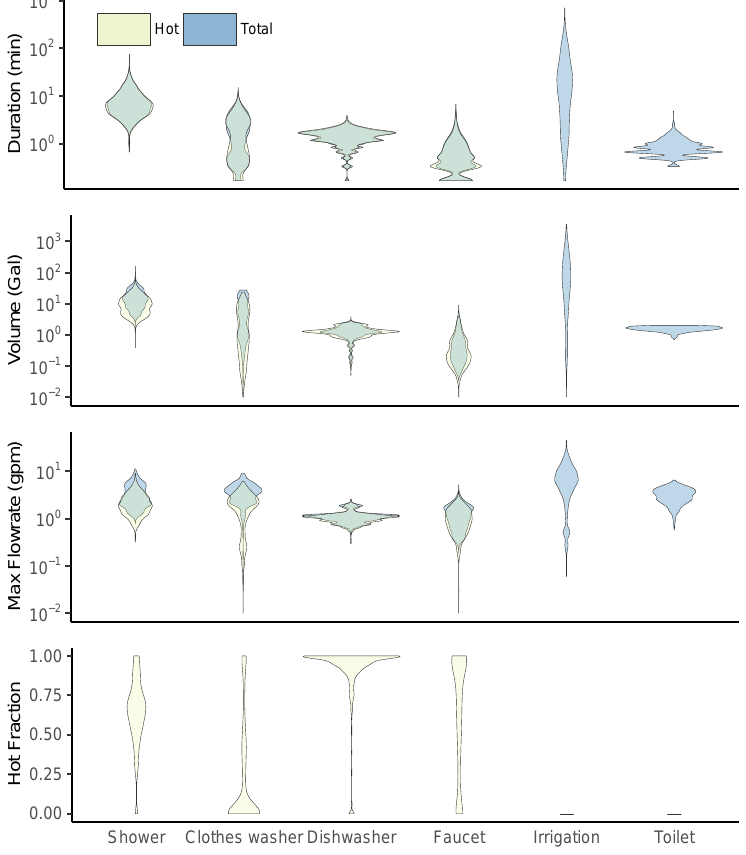
Figure 2. Distribution of water event features on the basis of duration, volume, and maximum flow rate for total and hot water use. Hot-water fraction is also plotted. Distributions for hot water features have similar shapes relative to total water use features, although natural groupings between appliances emerge on the basis of hot-water